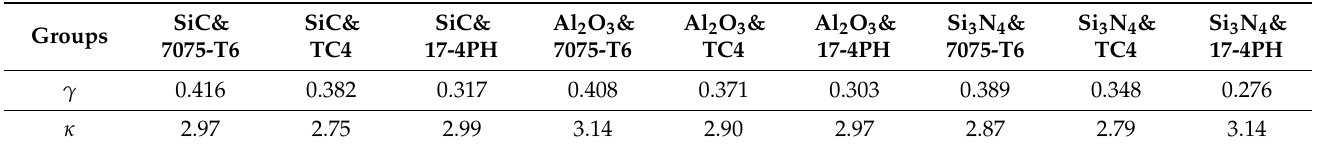
Table 4. γ and κ for the nine groups of ceramic pressure housings.